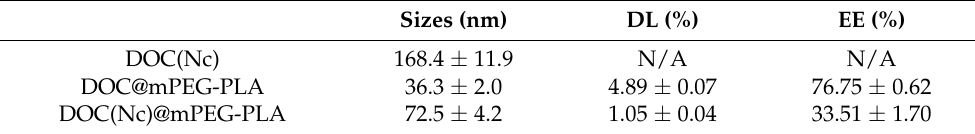
Figure 2. The effects of mPEG-PLA usage and hydration temperatures on the particle sizes, or encapsulation efficacy ( A , C ), and drug loading ( B , D ) of DOC(Nc)@mPEG-PLA. ( n = 3). Table 1. The particle sizes, drug loading (DL), and encapsulation efficiency (EE) of different formula- tions. (mean ± SD, n =